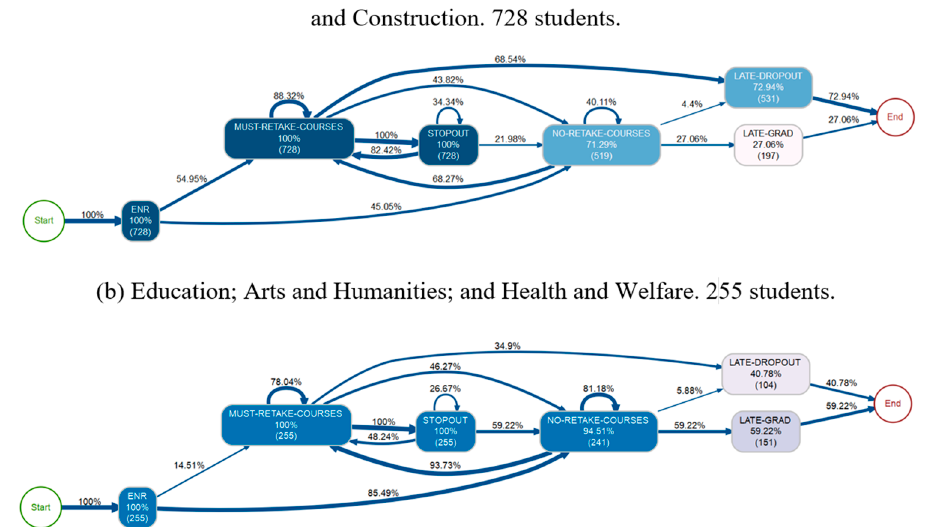
Figure 3. ( a , b ) Educational trajectories in high-failure rate courses, according to the RETAKE- STOPOUT model, including only students who had at least one MUST-RETAKE-COURSES > STOPOUT transition, did not have NO-RETAKE-COURSES > STOPOUT transitions, and ended in LATE-DROPOUT or LATE-GRAD. The darker color of the nodes represents a higher percentage of students who went through a state. The thickness of the arrows represents the percentage of students who had transitions between both states. All values are percentages in relation to the total number of students included in the model.